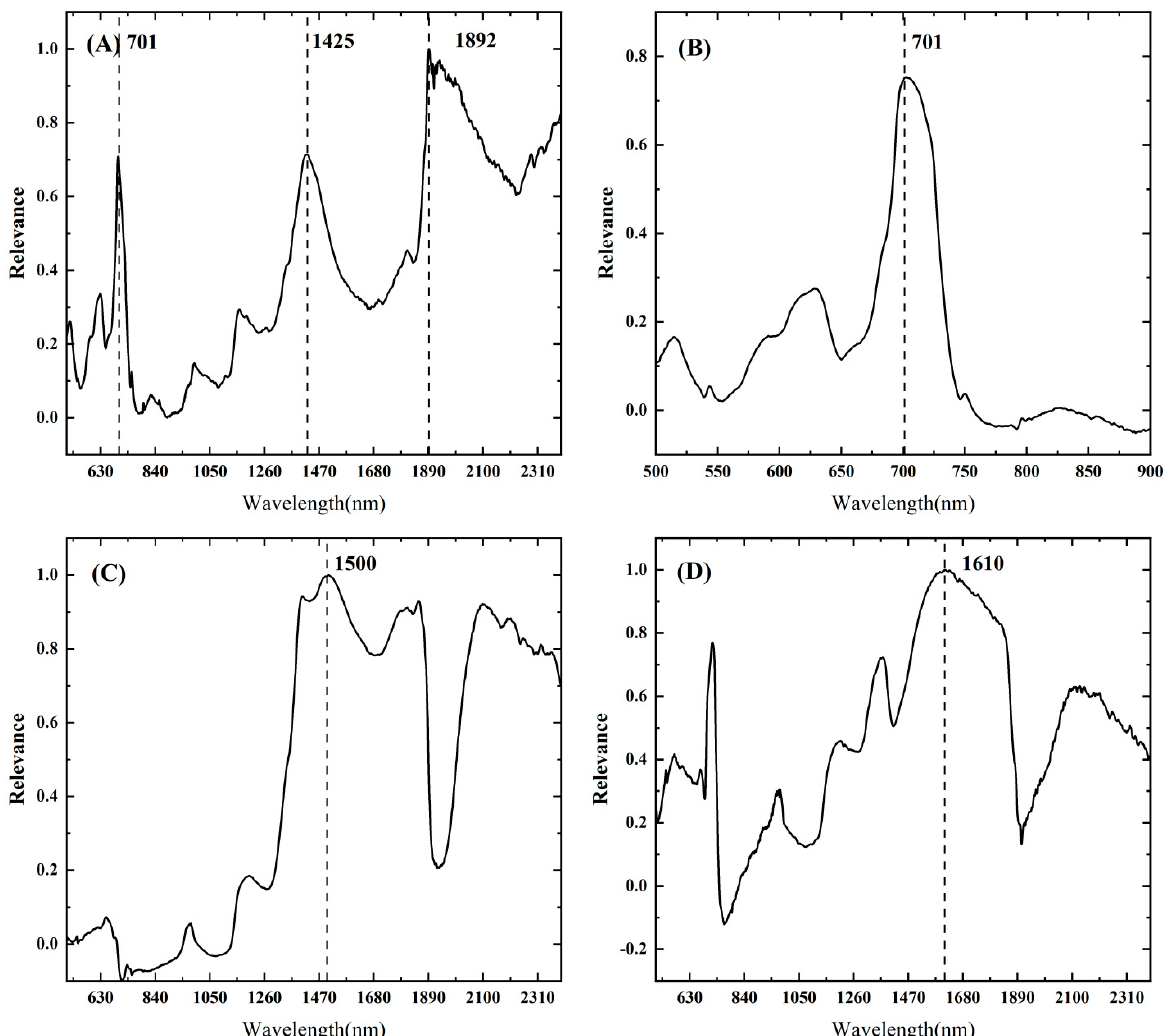
Figure 6. Correlation analysis of single wavelengths based on the Relief–F algorithm for VW severity ( A ), Chla ( B ), EWT ( C ), and Leaf_T ( D ).